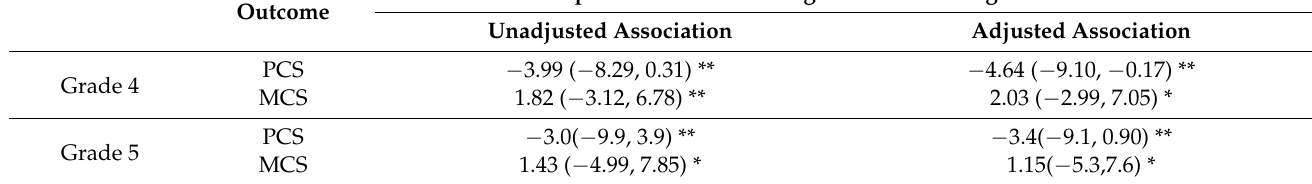
Table 4. Relationship between changes in the physical and mental component of HRQOL and medication non-adherence (MGLS).